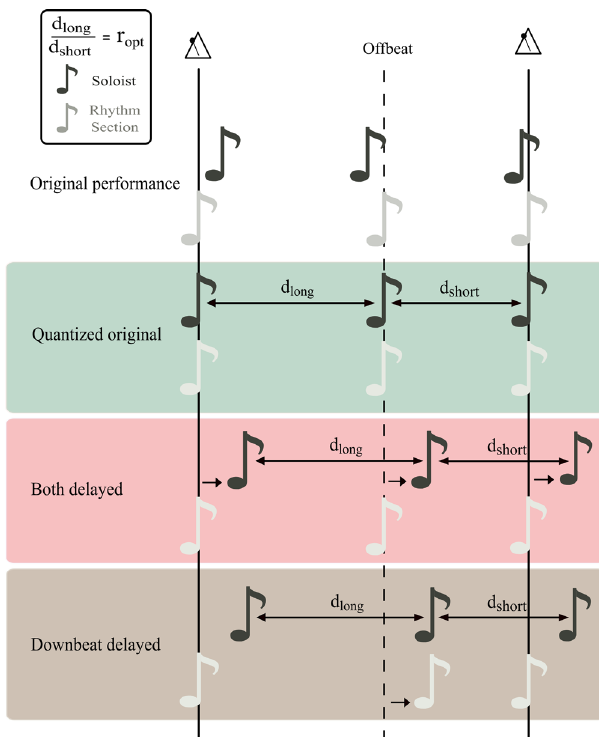
Fig. 3 Timing manipulations. Schematic representation of the timing manipulations we used in the experiment to probe the effects of microtiming deviations on the swing feel. Importantly, all manipulations were done so as to keep the same swing ratio for the soloist (i.e., piano). Full lines represent exact quarter note positions (metronome beats). The dashed line shows the position of the offbeats corresponding to a chosen “ optimal ” swing-ratio, referred to as r opt in the upper-left frame. Black notes and gray notes denote timing positions of soloist and rhythm section, respectively, in the different manipulations. In the “ quantized original ” version (green background) underlying all further manipulations, the microtiming deviations of the soloist's original performance are suppressed and the notes are aligned with the grid. In the “ both delayed ” version (red background), all notes of the soloist are delayed by 85 ticks. Finally, in the “ downbeat delayed ” version (brown background), additionally, the offbeats of the rhythm section are synchronized with the offbeats of the soloist. This procedure creates downbeat delays of 85 ticks for the soloist without changing the soloist's swing ratio, but increases the swing ratio of the rhythm